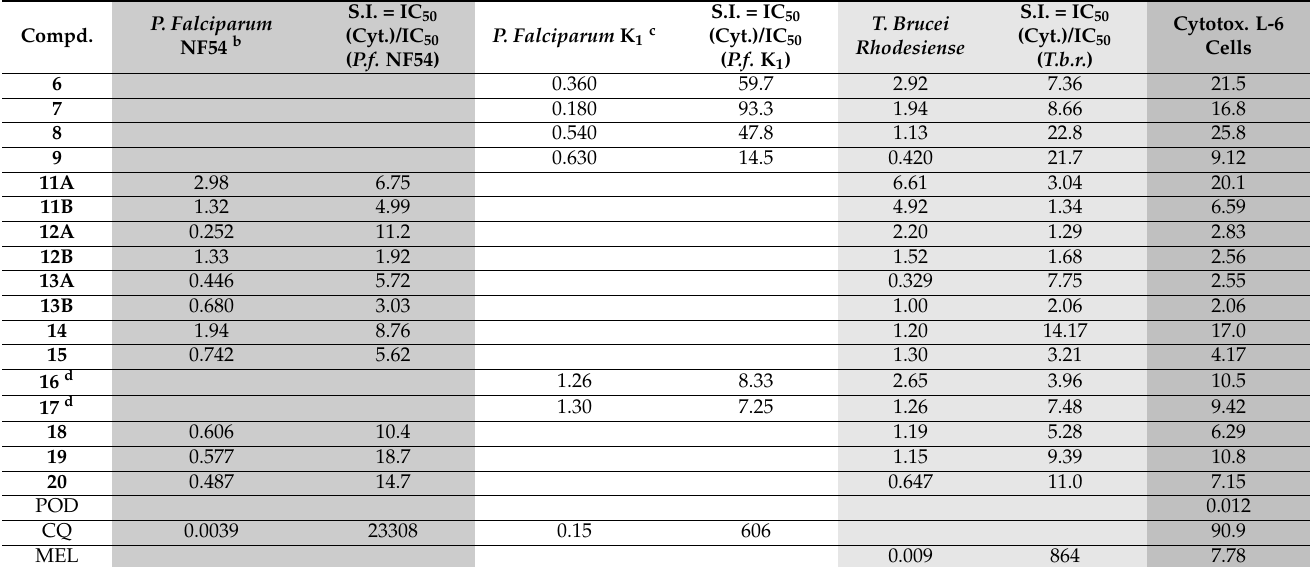
Table 1. Activities of compounds 6 – 20 against P. falciparum NF54, P. falciparum K 1 , T. brucei